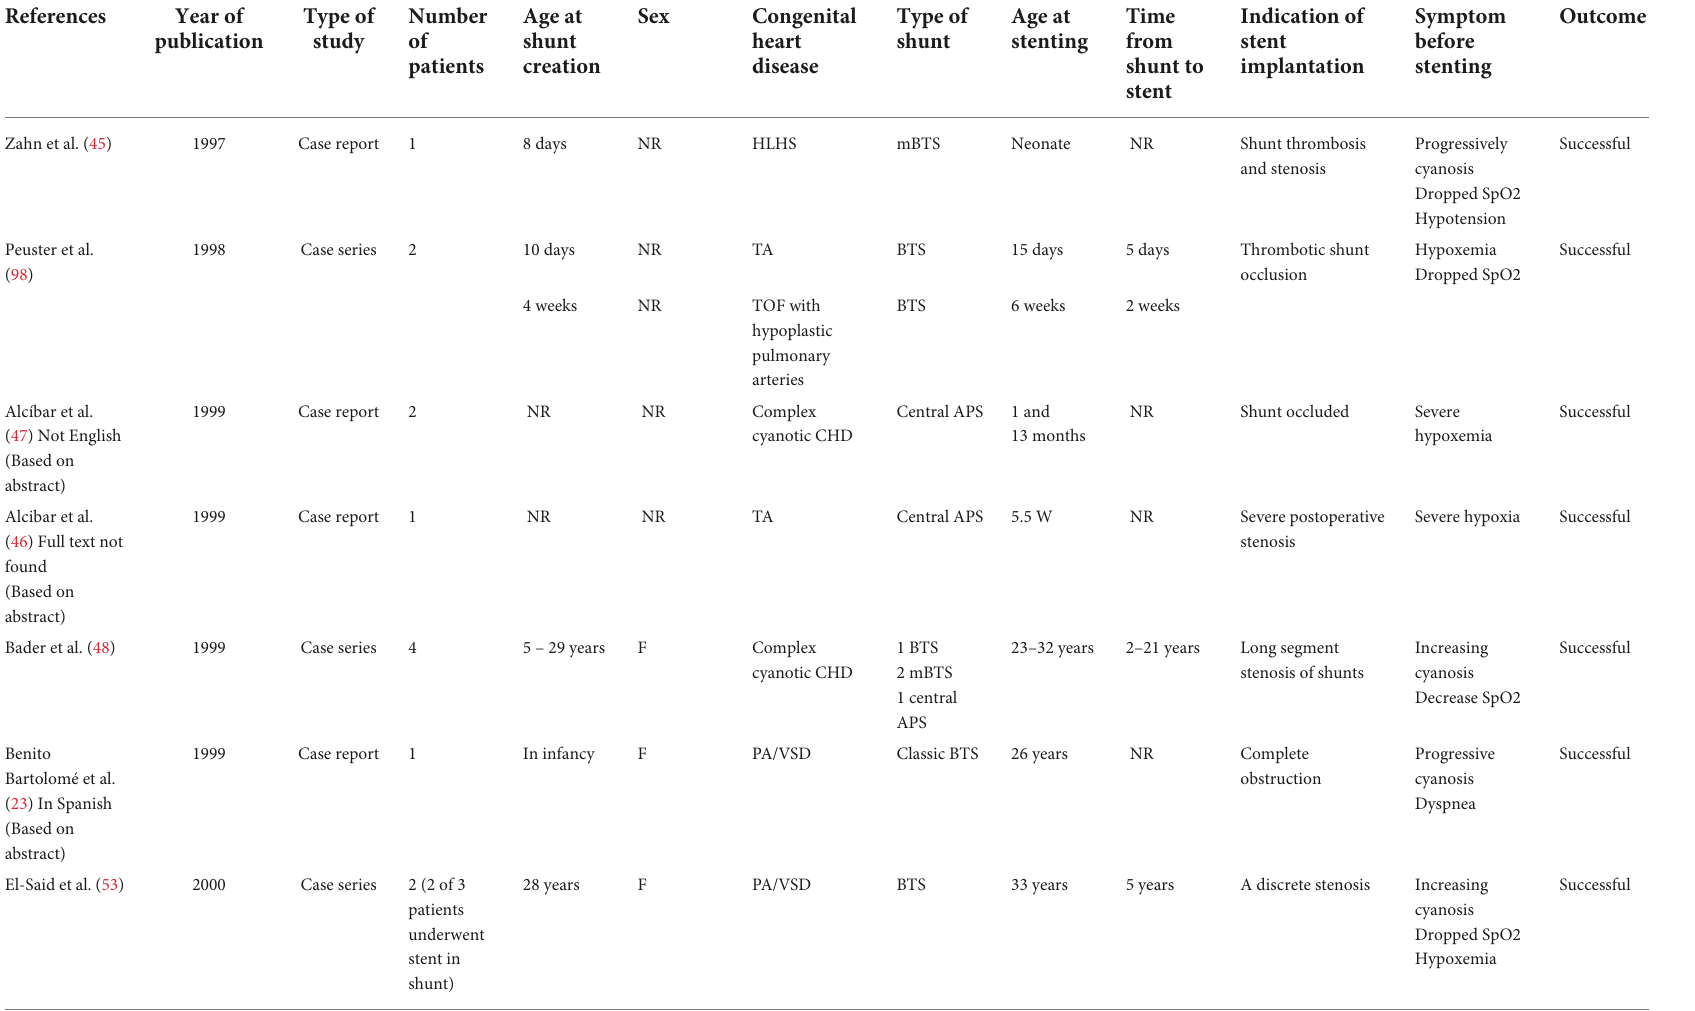
TABLE 1 Characteristics of the